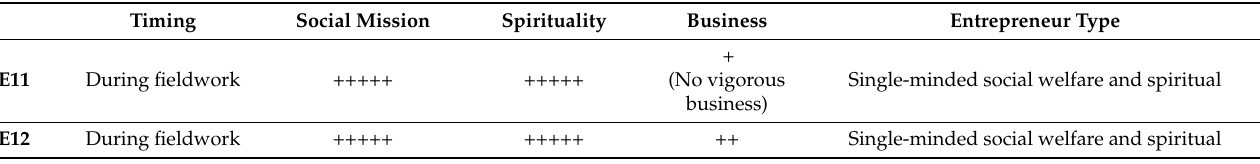
Table 6. Emphasis on institutional logics (single-minded social welfare and spiritual entrepreneurs). Timing Social Mission Spirituality Business Entrepreneur Type + SE11 During fieldwork +++++ +++++ (No